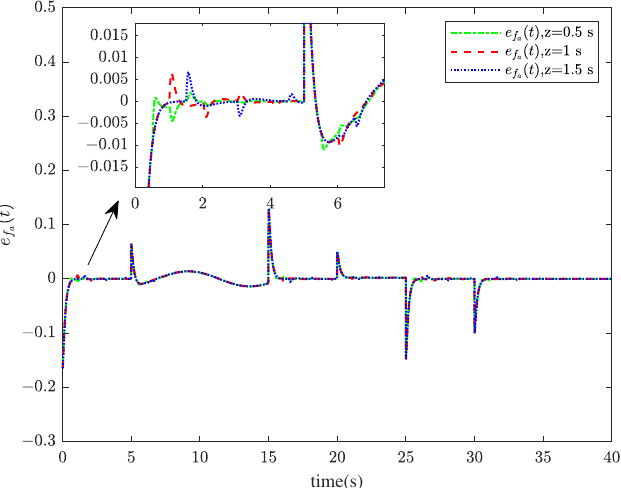
( t ) when z = 0.5 s, 1 s, 1.5 s. a